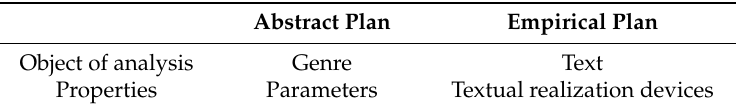
Table 1. Levels and concepts of